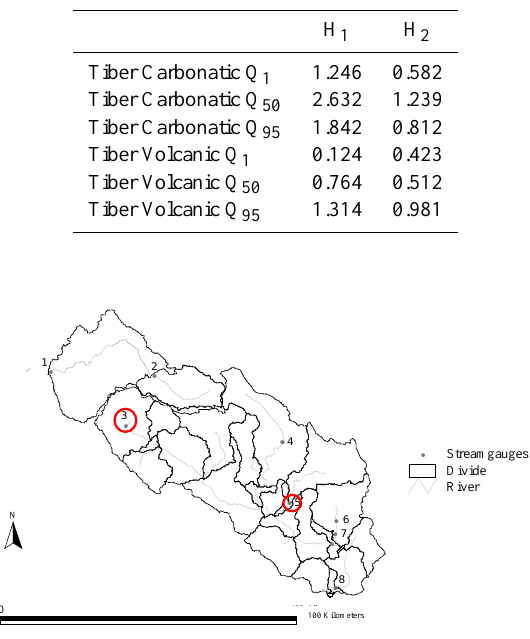
Fig. 6. Region 4 (Apennine basins), with gauged sites used to re- gionalize the stochastic index flow model. The red circles high- light the position of the stations used for the testing of the modified stochastic index flow model.